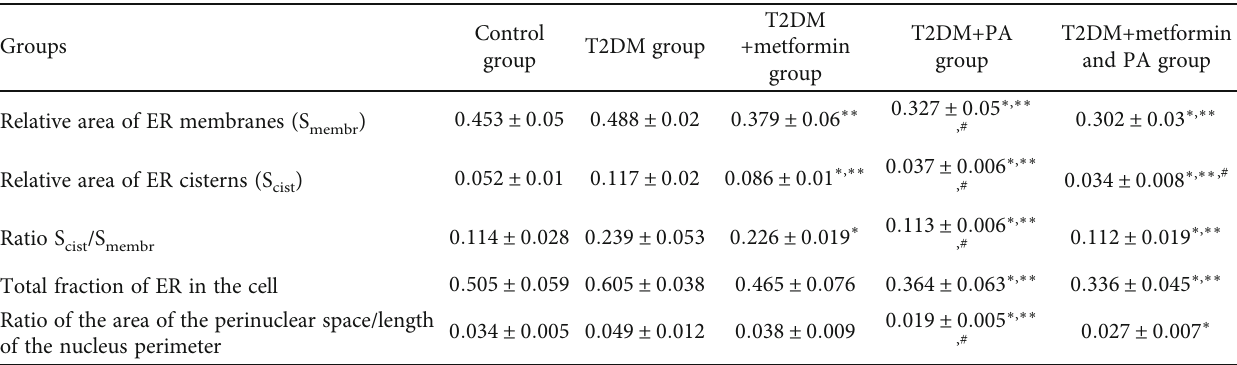
Total fraction of ER in the cell Ratio of the area of the perinuclear space/length of the nucleus perimeter Note: Values are given as mean ± SEM ( n = 12 ); ∗ p < 0 : 05 vs. control, ∗∗ p < 0 : 05 vs. T2DM, # p < 0 : 05 vs. metformin administration, and @ p < 0 : 05 vs. PA